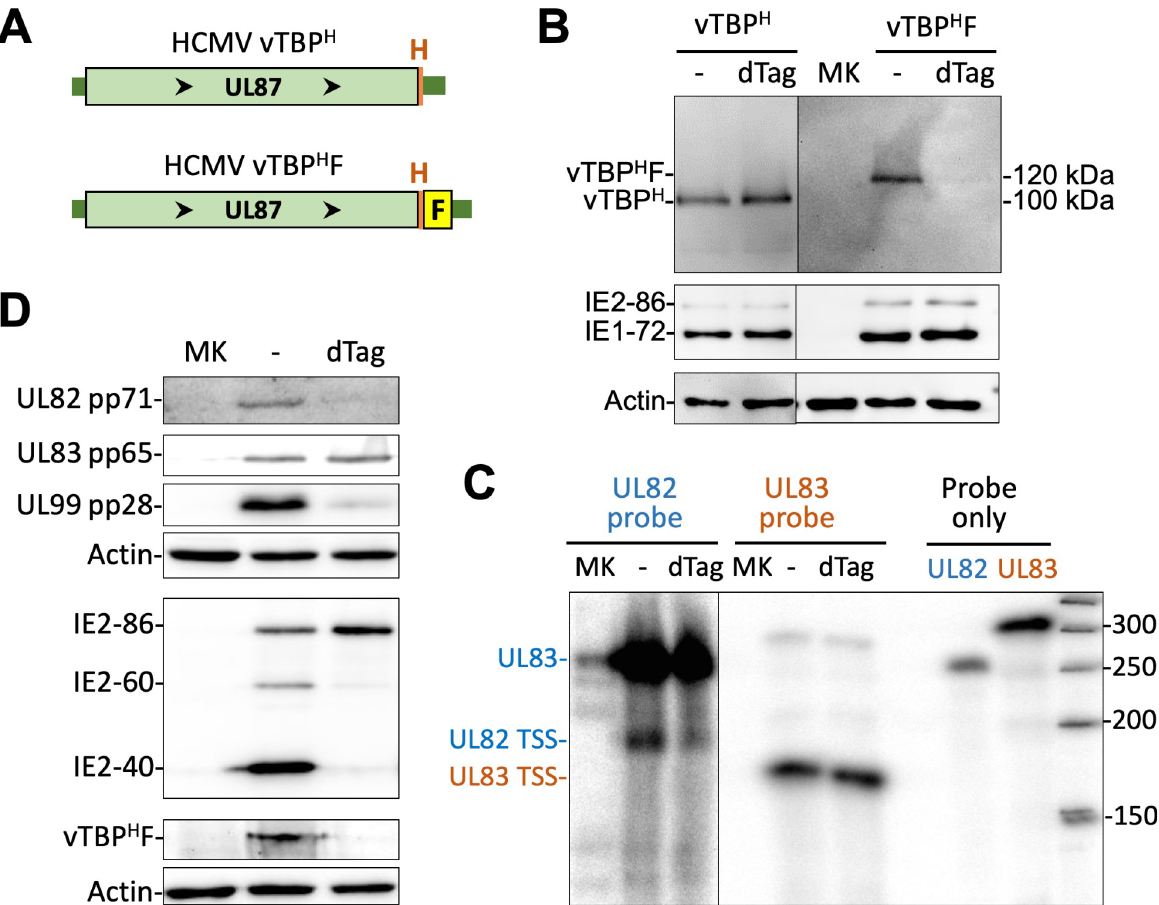
Fig 7. vTBP depletion does not affect UL83 promoter-dependent expression in late infection. (A) The carboxy end of vTBP, encoded by UL87, was tagged with the HA epitope alone (vTBP H ) or HA plus FKBP12M (vTBP H F) in the HCMV Towne genome. (B) HCMV vTBP H - and vTBP H F- infected HFF tested in parallel were analyzed by western blot for the indicated proteins at 72 h pi plus or minus dTAG at 66–72 h pi. Different imaging exposure times were used to view vTBP H - and vTBP H F bands. (C) HCMV vTBP H F-infected HFF were analyzed by RPA at 72 h pi plus or minus 6h-dTAG, using riboprobes depicted in Fig 3B, and bands were quantified using a phosphorimager. (D) At 72 h pi with HCMV vTBP H F, dTag was added or not for 24 h and then the indicated proteins were analyzed by western blot.